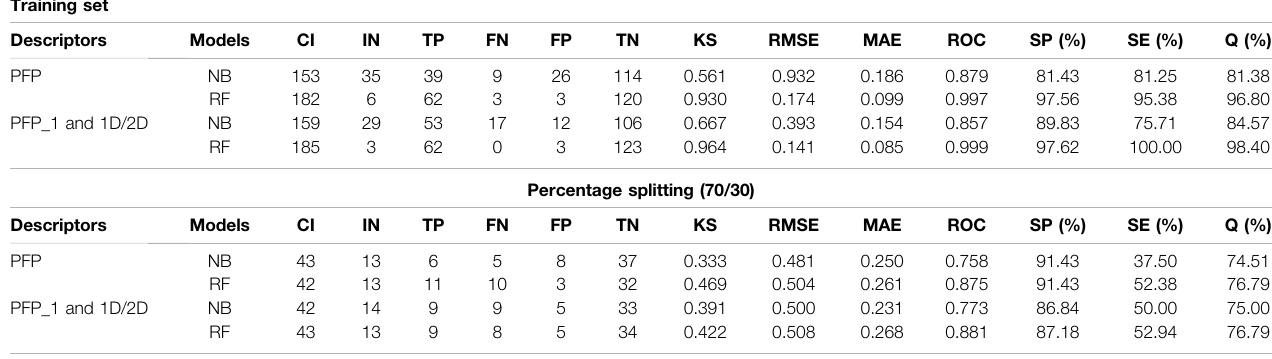
TABLE 1 | Performance of the Naïve Bayes and random forest classi fi